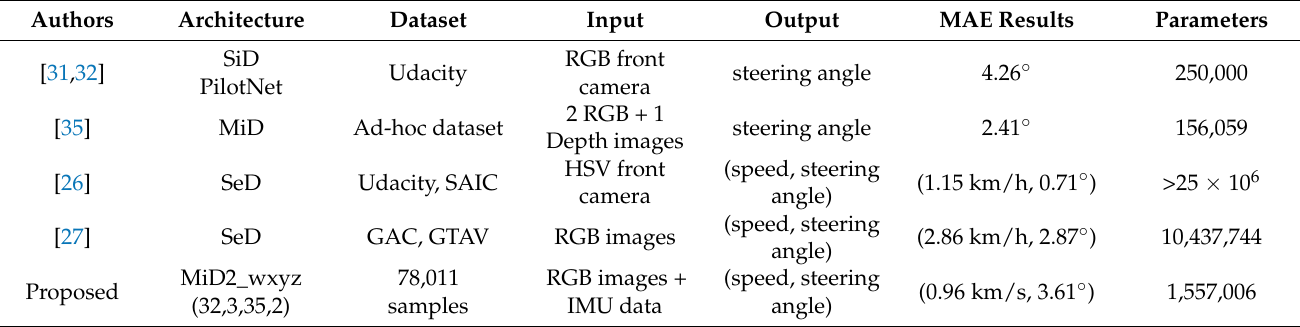
Table 6. MAPE metric obtained during the 2DCB optimization for the SiD1, SiD2, MiD1, MiD2, SeD1 and Se2 architectures. Authors